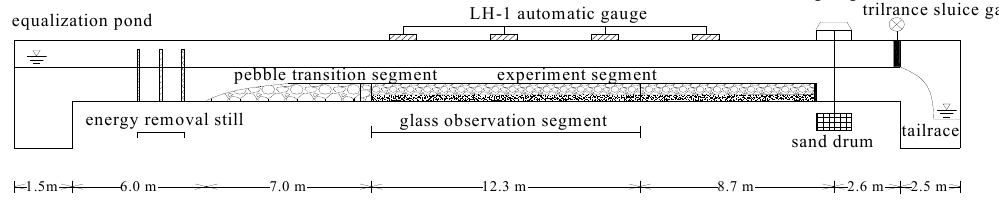
Figure 1. Line sketch of the experimental setup.